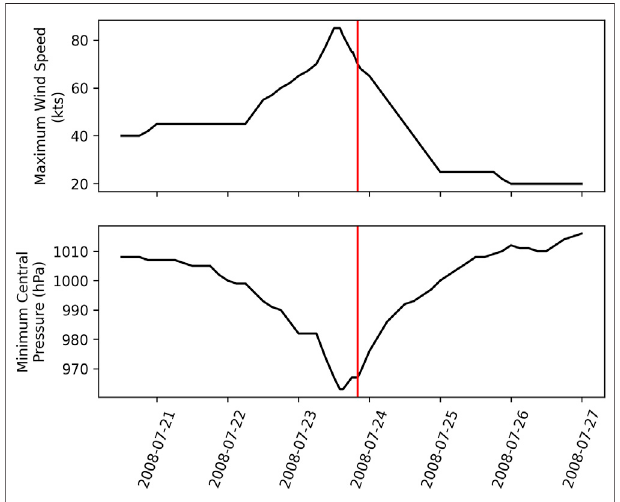
FIGURE 7 | Maximum wind speed (top) and minimum central pressure (bottom) for Hurricane Dolly (2008). The red line depicts the fi nal landfall.